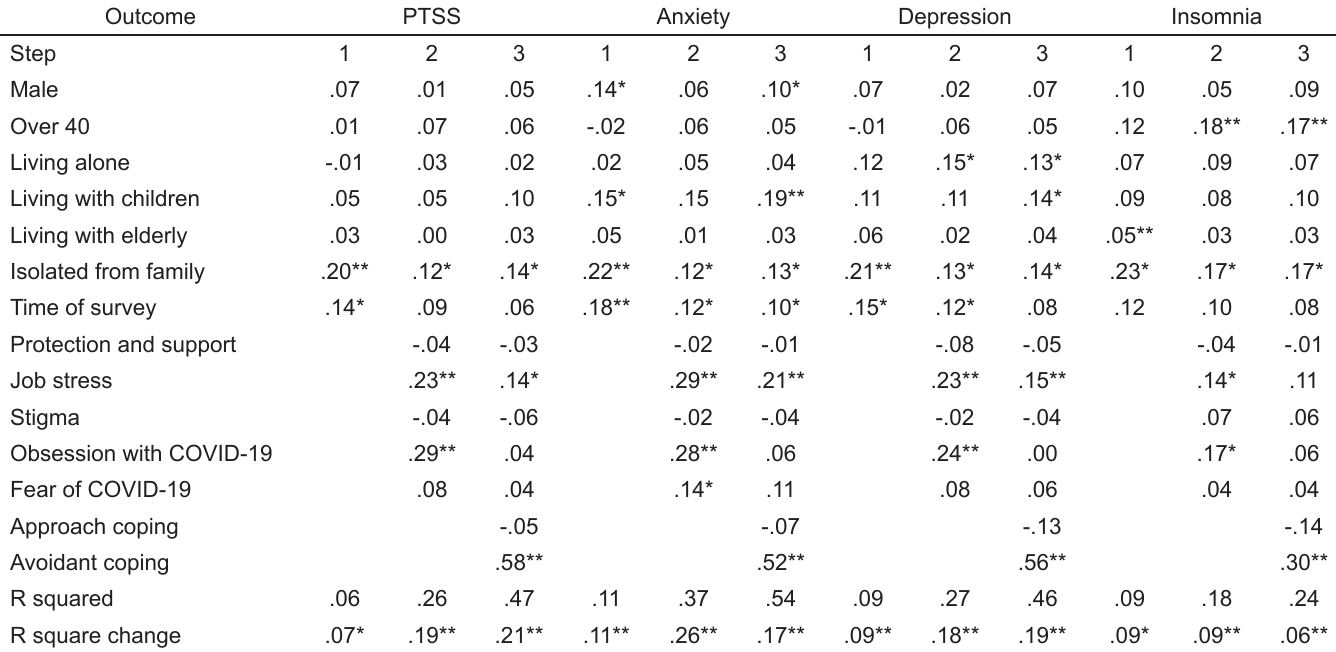
Table 6. Three-step hierarchical multiple regression analyses for mental health